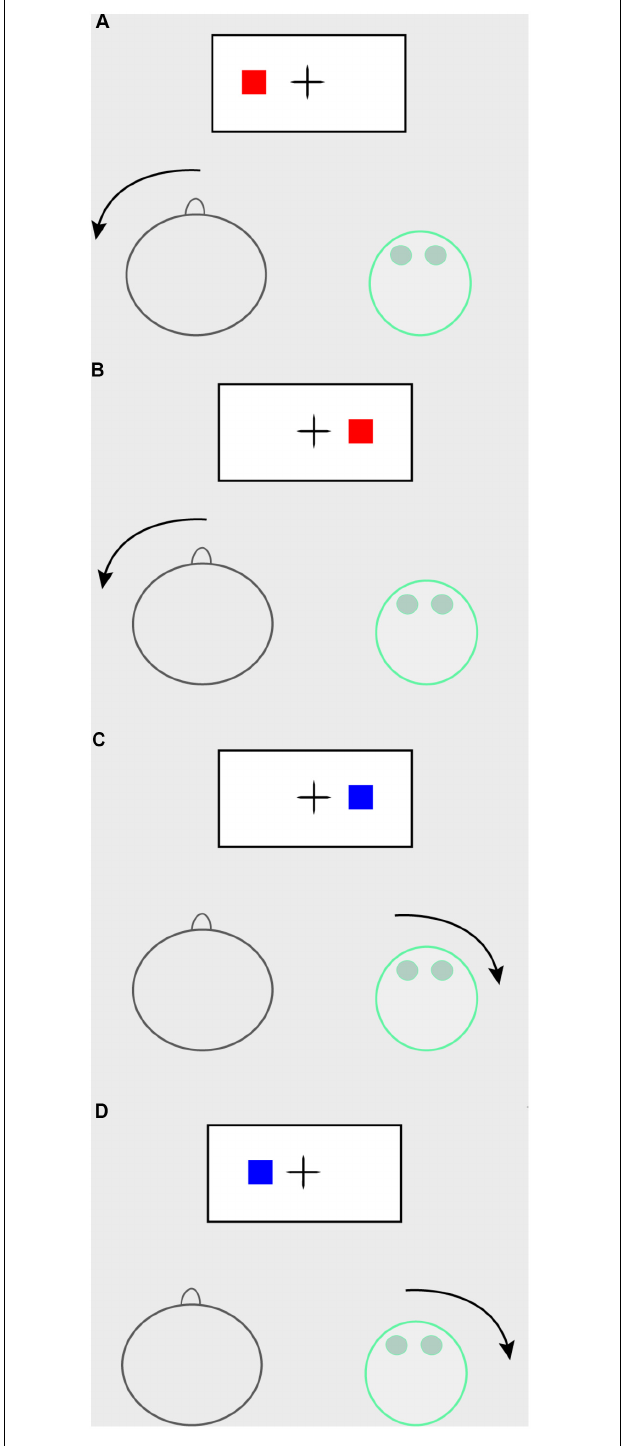
FIGURE 2 | Joint Simon task setup. In this example of the joint Simon task, the participant has to respond to red stimuli, whereas the robot has to respond to blue stimuli. The participant has to respond with a large head movement to the left; the robot has to respond with a large head movement to the right. (A) Congruent trial for the participant (stimulus on the participant’s